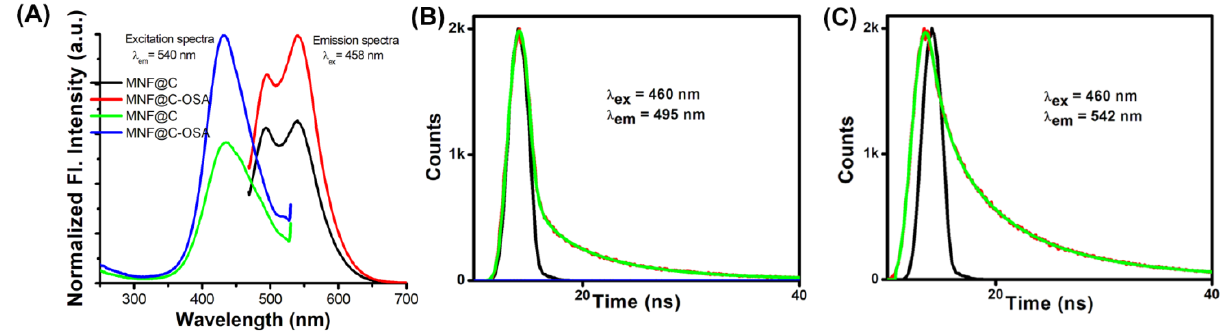
Figure 3. ( A ) Emission and excitation spectra of the MNF@C and MNF@C-OSA dots. ( B ) Time-resolved fluorescence image of MNF@C-OSAs at λ em = 495 nm. ( C ) Time-resolved fluorescence image of MNF@C-OSAs at λ em = 542 nm. Table 1. Decay profile of MNF@C-OSAs.